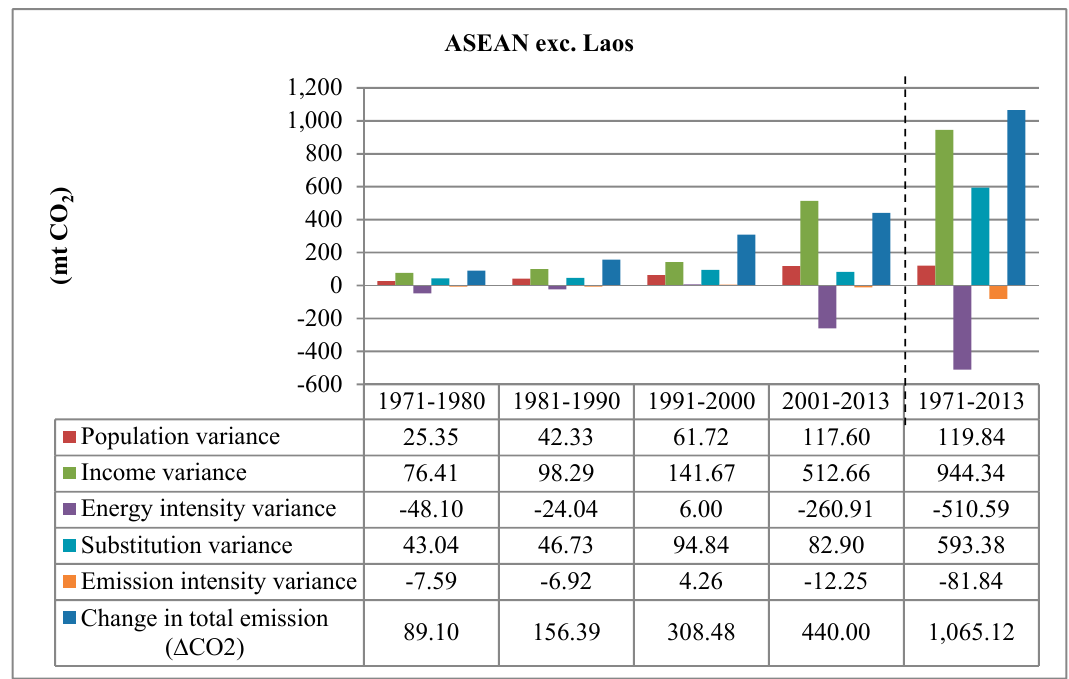
Figure 9. Decomposition results of CO 2 emissions in ASEAN.